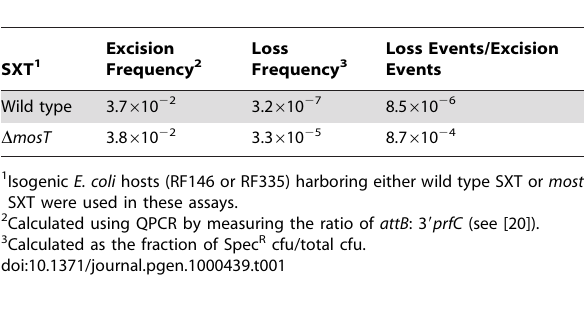
Table 1. Comparison of SXT excision and loss frequencies.